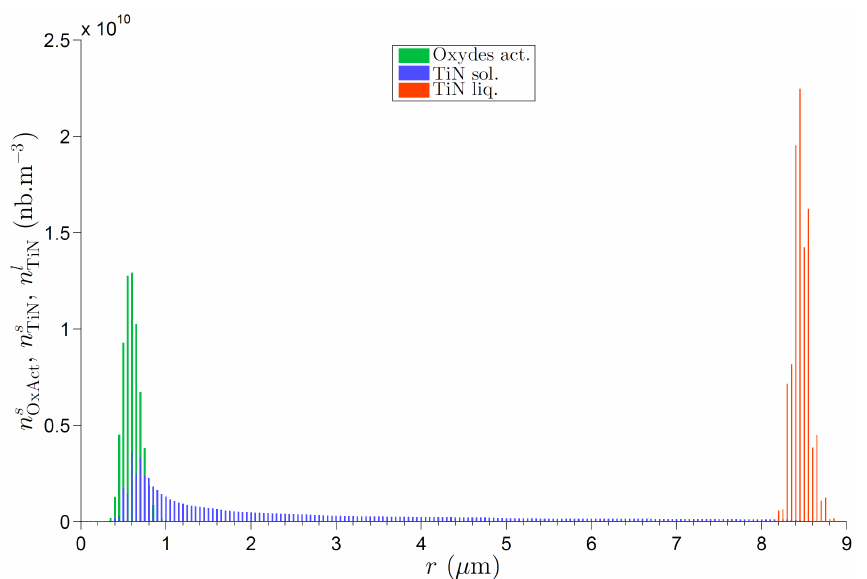
Figure 5. Final computed TiN size distributions in the (residual) liquid and solid phase, and activated oxides size